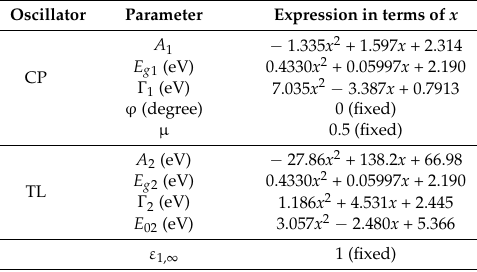
Table 2. Expressions given in terms of IGS composition x with x ≤ 0.45 for the critical point (CP) and Tauc-Lorentz (TL) oscillator parameters that define the ( ε 1 , ε 2 ) spectra. Among the ten possible variable parameters of this oscillator model, three are fixed as shown and two are coupled in the fit. For the coupled parameters, the Tauc gap of the TL oscillator is equated to the fundamental bandgap, which is the resonance energy of the CP oscillator. This latter oscillator dominates the absorption onset over this range of x . The polynomial expressions are appropriate for an IGS temperature of 400 ◦ C and a bulk layer thickness in the range of 3500–4100